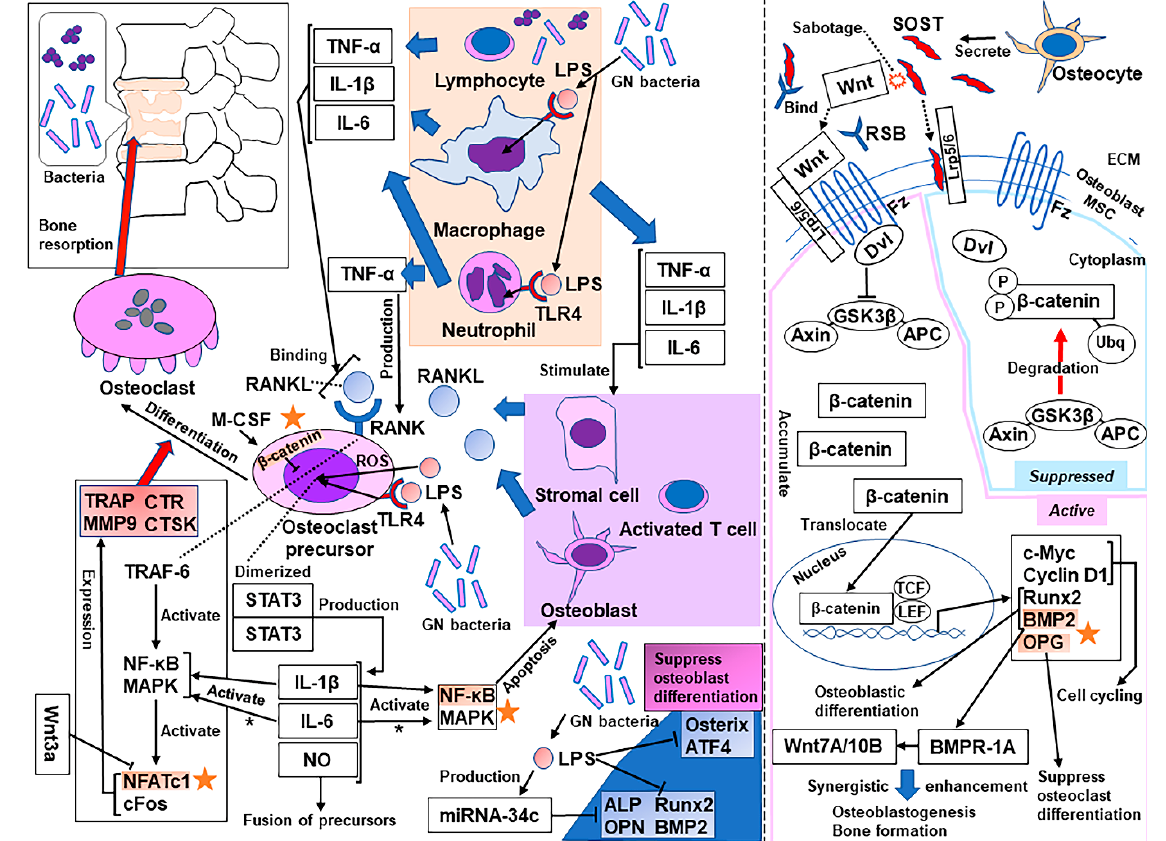
Figure 2. An overview of the mechanisms of bone loss secondary to infection and the effects of romosozumab to block these pathways. Orange stars indicate the sites targeted by romosozumab. * In low-level (10 ng/mL) RANKL (in contrast, IL-6 suppresses NF-kB and MAPK signaling in high-level (50 ng/mL) RANKL). BMPR-1A, BMP receptor type IA; Dvl, Disheveled; ECM, extracellular matrix; Fz, Frizzled; GN, Gram-negative; M-CSF, macrophage-colony-stimulating factor; NO, nitrogen oxide; ROS, reactive oxygen species; RSB, romosozumab; SOST, sclerostin; Ubq, ubiquitination.